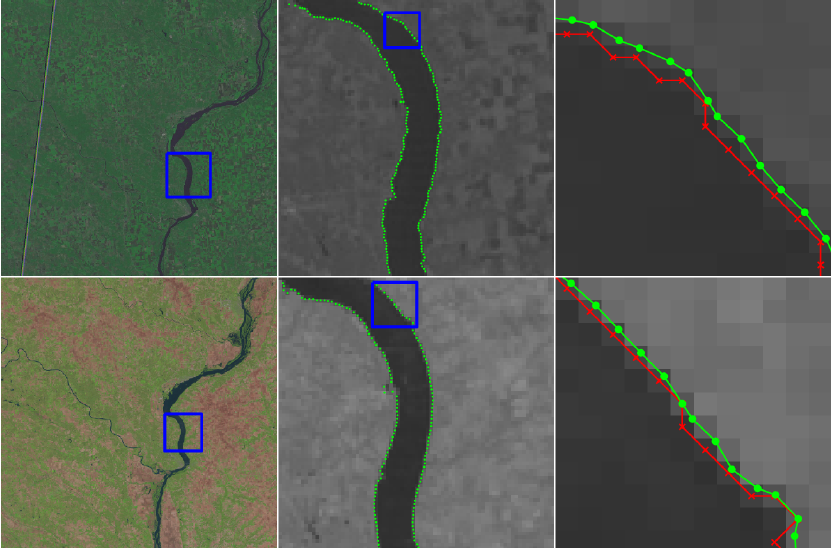
Figure 10. Images of the Mississippi River taken by the Landsat-5 spacecraft, where we seek to localize the river banks. The top image (LM05 L1TP_025032_20120830_20180521_01_T2) was collected on 21 May 2018 by the Multispectral Scanner System (MSS) and shows the river during normal conditions. The bottom image (LT05_L1TP_025032 20110508_20160902_01_T1) was collected on 2 September 2011 by the thematic mapper (TM) and shows the river after a major flooding event. The red denote pixel-level edge estimates and green dots denote the refined subpixel localization estimates. Image data is available from the U.S. Geological Survey (USGS) [30].